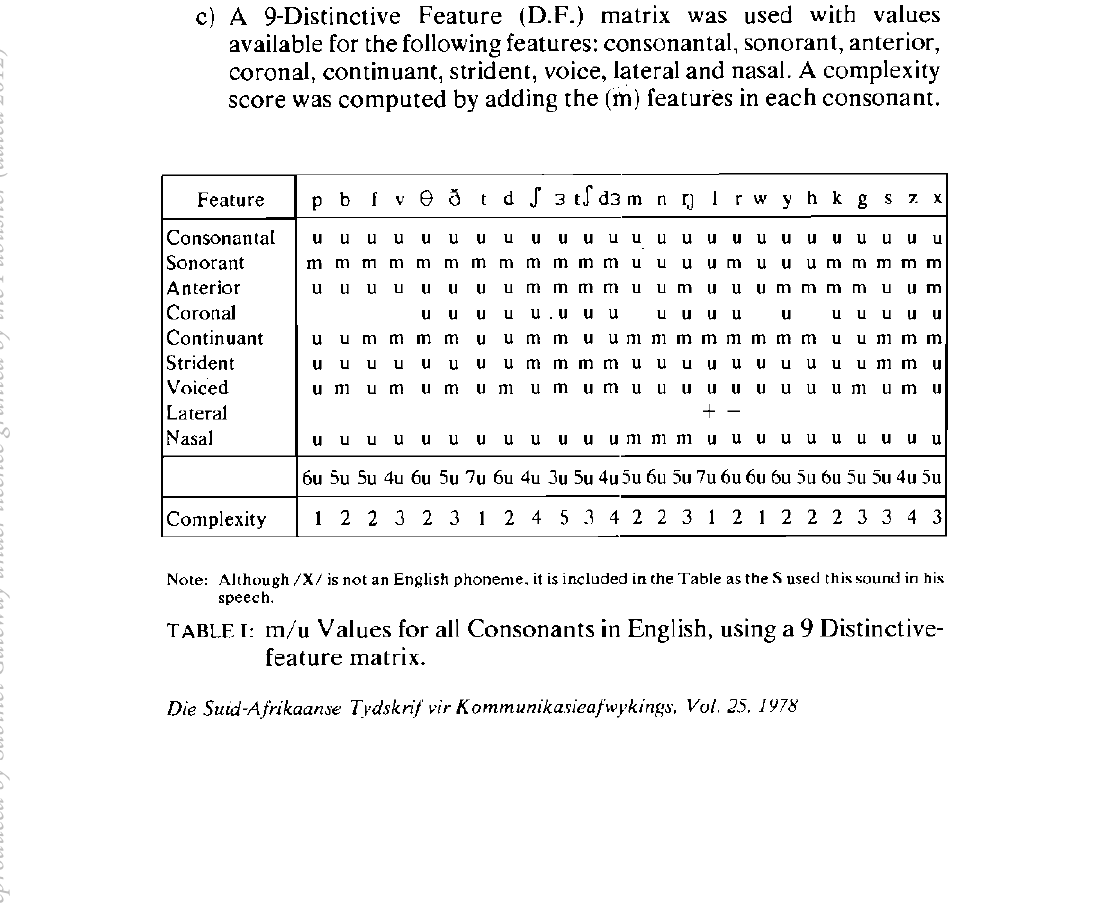
TABLE I: m/u Values for all Consonants in English, using a 9 Distinctive- feature